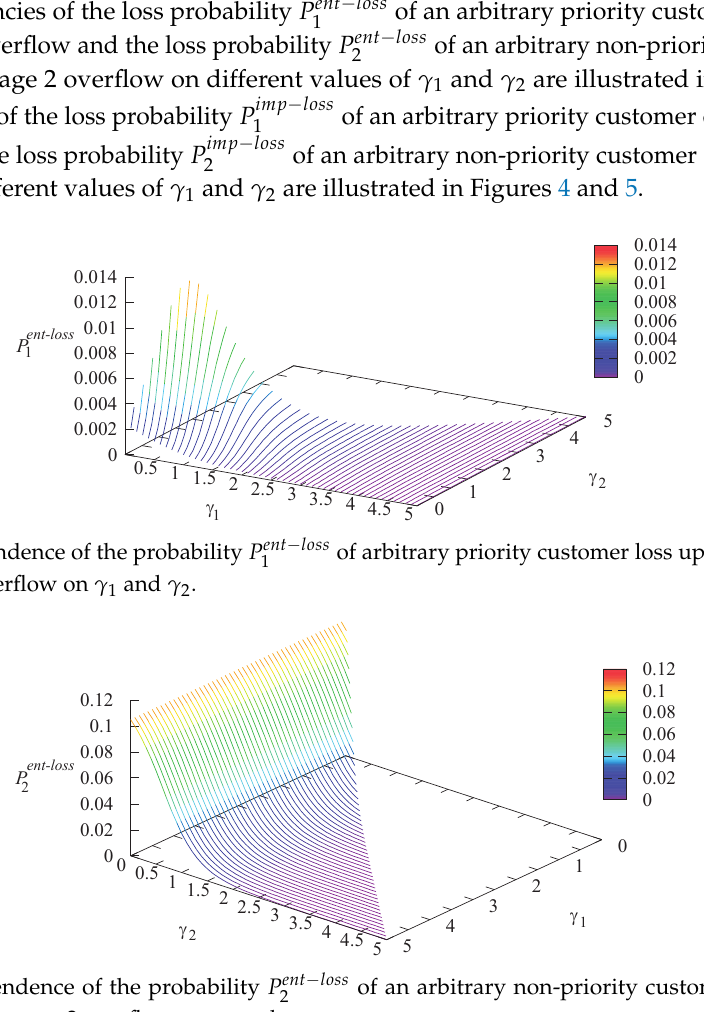
of an arbitrary non-priority customer loss upon 2